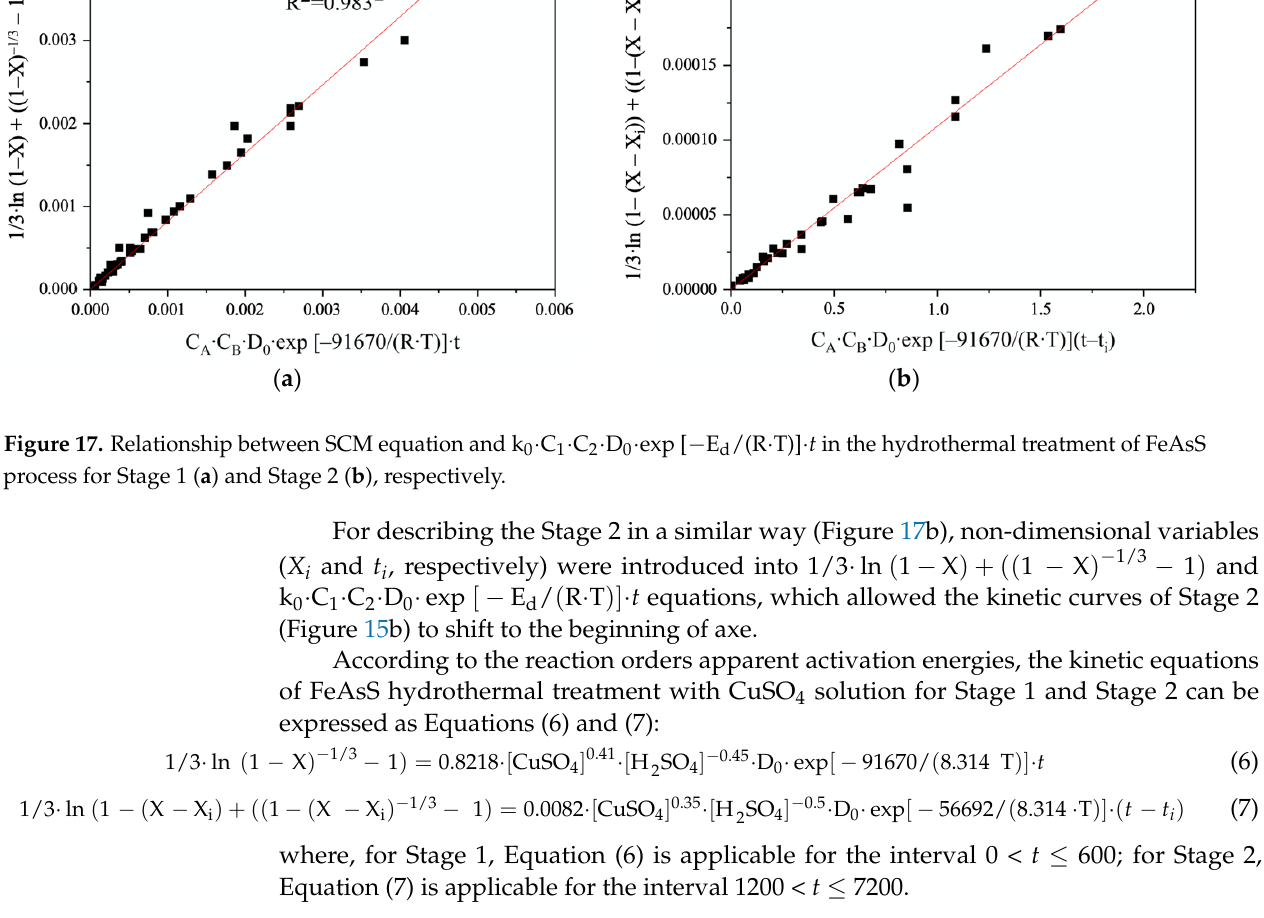
16 of 19 Figure 16. Arrhenius plot for Stage 1 ( a ) and Stage 2 ( b ). The reaction order with respect to CuSO 4 and H 2 SO 4 was calculated as 0.41 and − 0.45 for Stage 1 and as 0.35 and − 0.5 (Figures 5 and 6) for Stage 2. The fractional order with respect to the reagents is also typical for hydrothermal processes mentioned above. The rate-controlling step of the process can also be identified from the temperature coefficient of the reaction speed. For the diffusion-controlled process, the temperature co- efficient is generally 1.3 – 1.6, while for the chemical reaction control process, the tempera- ture coefficient is ≥ 2. The experimental results in Figure 15 show that in the process of the reaction temperature rising from 443 to 523 K with the temperature step 20 K, the average temperature coefficient is 1.7 for Stage 1 (Figure 15a) and 1.6 for Stage 2 (Figure 15b), which corresponds to the diffusional control process. According to the balance experiments, the process of FeAsS hydrothermal treatment with CuSO 4 solution is accompanied by the formation of H 2 SO 4 . As for stoichiometry, 1 mole of Fe (2+) and As (3+), 2 – 3 moles of Cu 0 , 1 – 2 moles of H 2 SO 4 and 0.5 – 1.5 moles S 0 are formed per mole of FeAsS. Thus, it is proposed that this process is described by reaction 3. 3.4. Establishment of the Kinetic Equations Although the general kinetic equation for FeAsS treatment with CuSO 4 solution can- not be determined, the process can be divided into two stages, and it is suggested that each stage is described by individual kinetics equation. The kinetics equations of the total apparent reaction rate constant were determined according to the above-mentioned re- sults, considering the effects of the initial concentration of CuSO 4 and H 2 SO 4 and reaction temperature. The rate expression for this hydrothermal process can be written as follows in Equation (5): 1/3·ln (1 - X) + ((1 - X) - 1/3 - 1) = k 0 ·C 1 ·C 2 ·D 0 ·exp[ - E d /(R·T)]· t